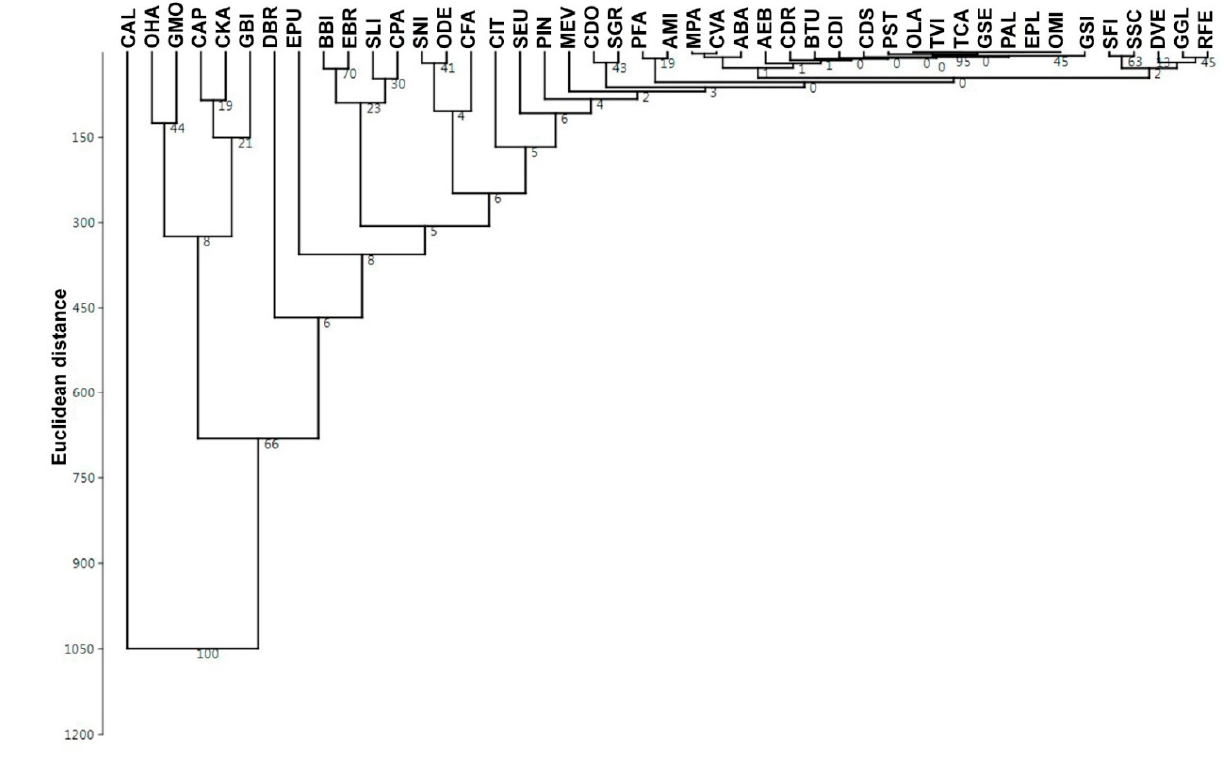
Figure 3. The Euclidean distances between the orthopteran species distributions in the Karasuk River Basin, SE West-Siberian Plain (Ward’s hierarchical clustering) (after original data [74], calculated by PAST 4.02 [75]): digits—supporting